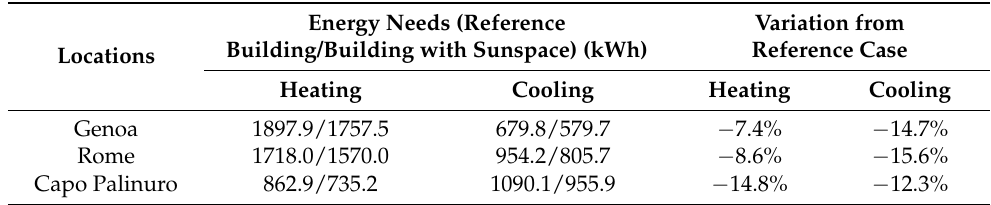
Table 10. Building’s annual energy needs and percentage change relatively to the reference case varying sun space’s location.